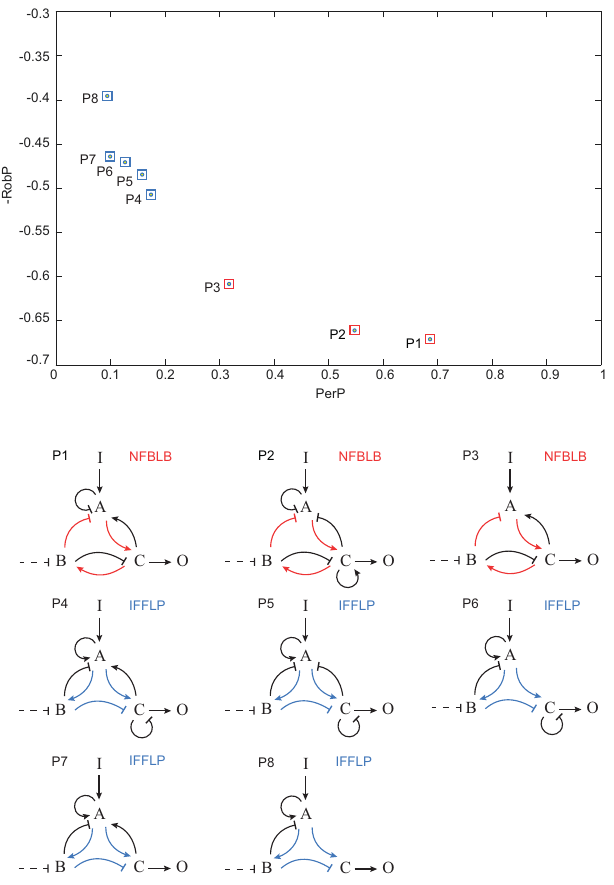
Figure 7. Pareto front (objective space) of Pareto optimal circuit